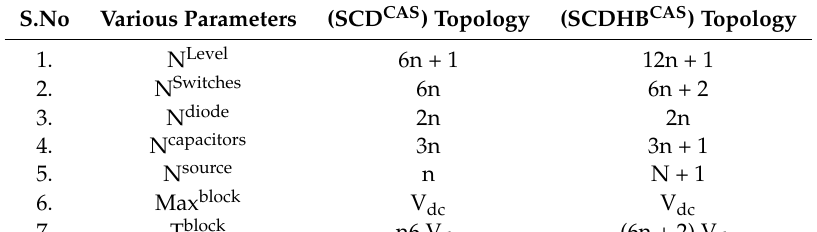
Table 2. Comparison of power components in the proposed topologies.